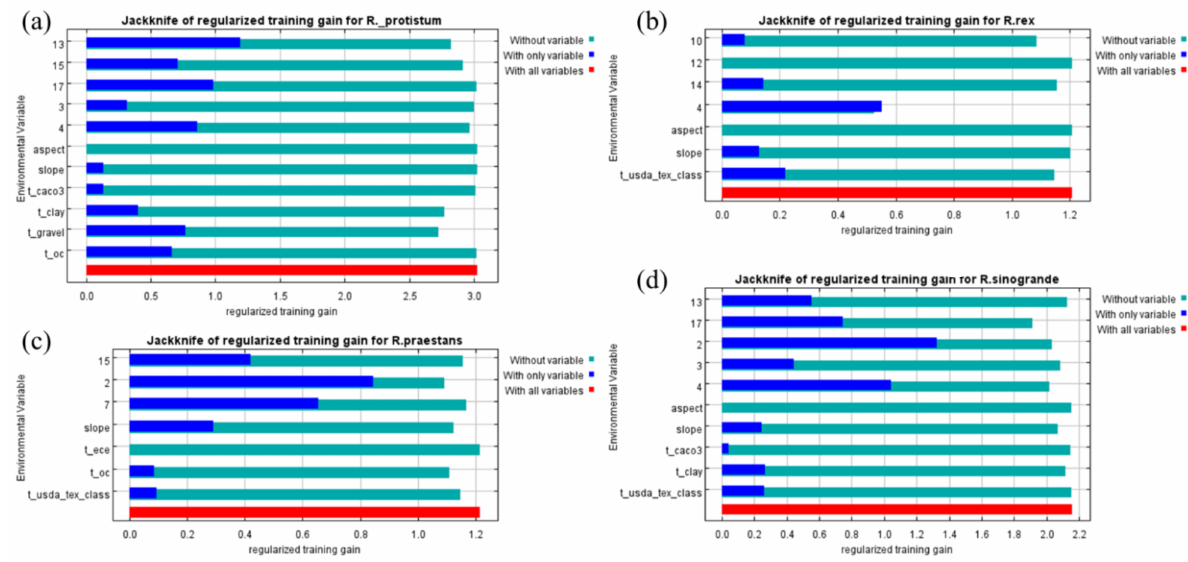
Figure A2. The Jackknife test of variables’ contribution for four Rhododendron species: ( a ) R. protistum , ( b ) R. rex subsp. rex , ( c ) R. praestans , ( d ) R. sinogrande